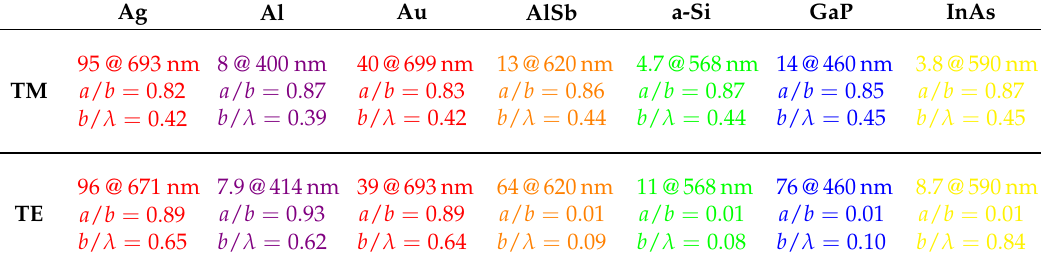
Table 1. Optimally -radiating cylindrical shells. Performance P rad / P inc (for each type of wave TM/TE in different rows) at specific wavelengths λ (indicated also by the corresponding color of the visible spectrum) and optimal geometric sizes ( a , b ) for most of the available materials (from Figure 2b) for which the proposed configuration of Figure 2c maximally multiplies the feeding field. Ag Al Au AlSb a-Si